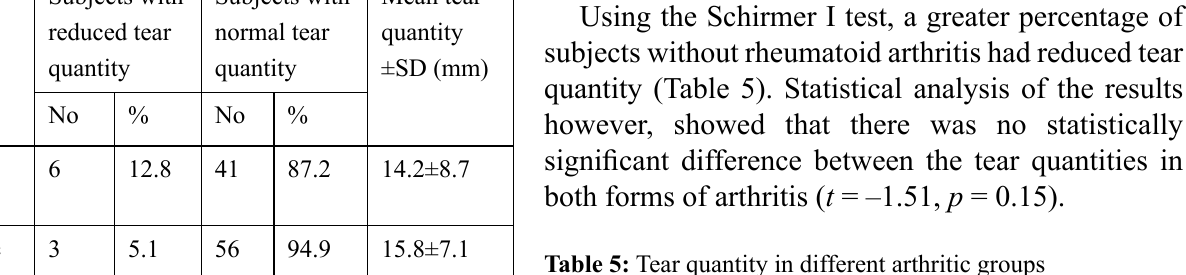
Table 2: Subjects with reduced tear quantity Group